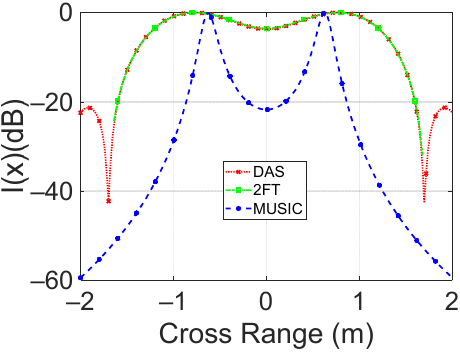
Figure 15. Comparison between the three considered techniques in the presence of two targets. The normalized intensity function versus cross-range distance is reported.